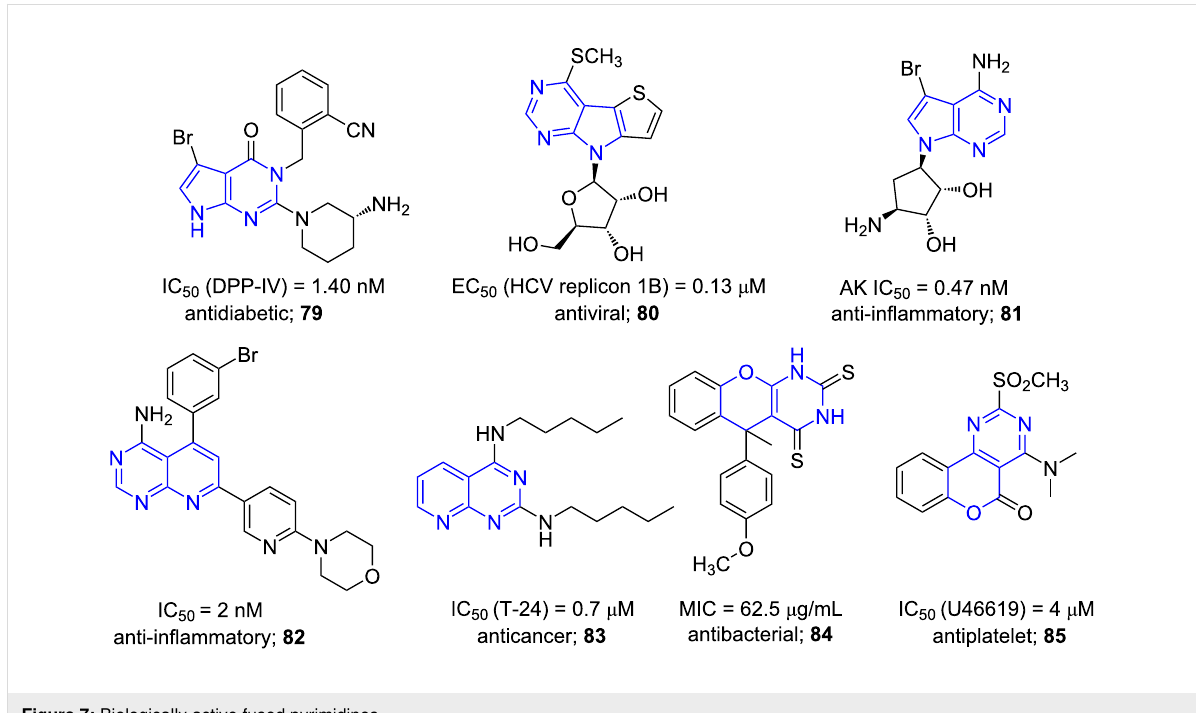
Figure 7: Biologically active fused pyrimidines.